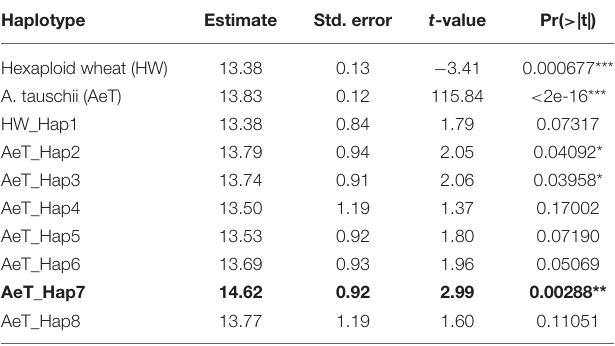
TABLE 5 | Chromosome 2D haplotypes variants associated with the spikelet number and HD and how they influence other traits in the introgression population.